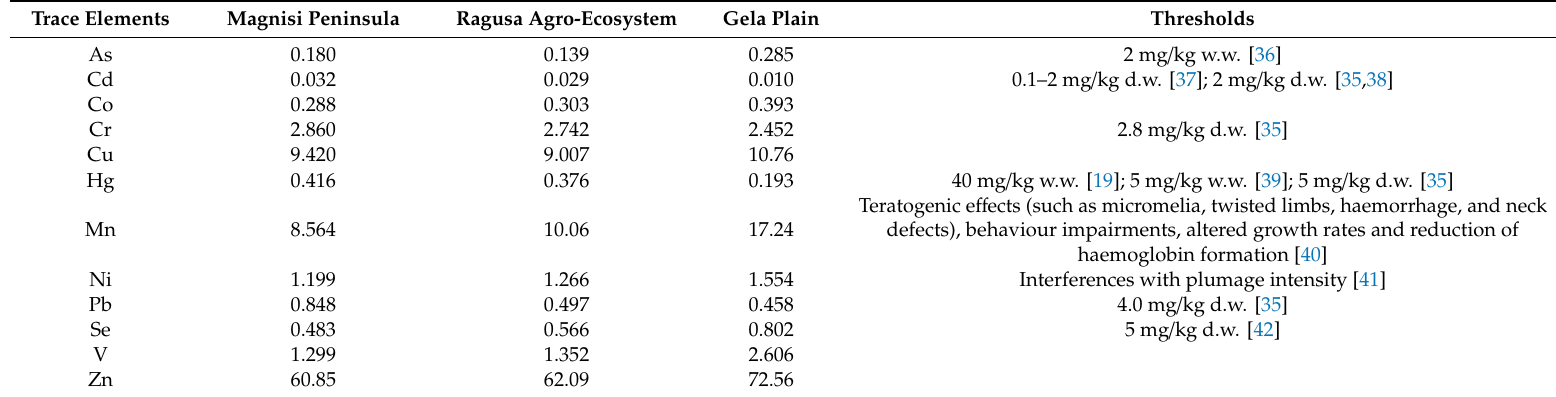
Table 1. Trace elements in abrased back feathers of the Stone Curlew sampled from the Magnisi peninsula (MP), Ragusa agro-ecosystem (RA) and Gela plain (GP) (in mg / kg d.w.), and the toxicological limits in other species.